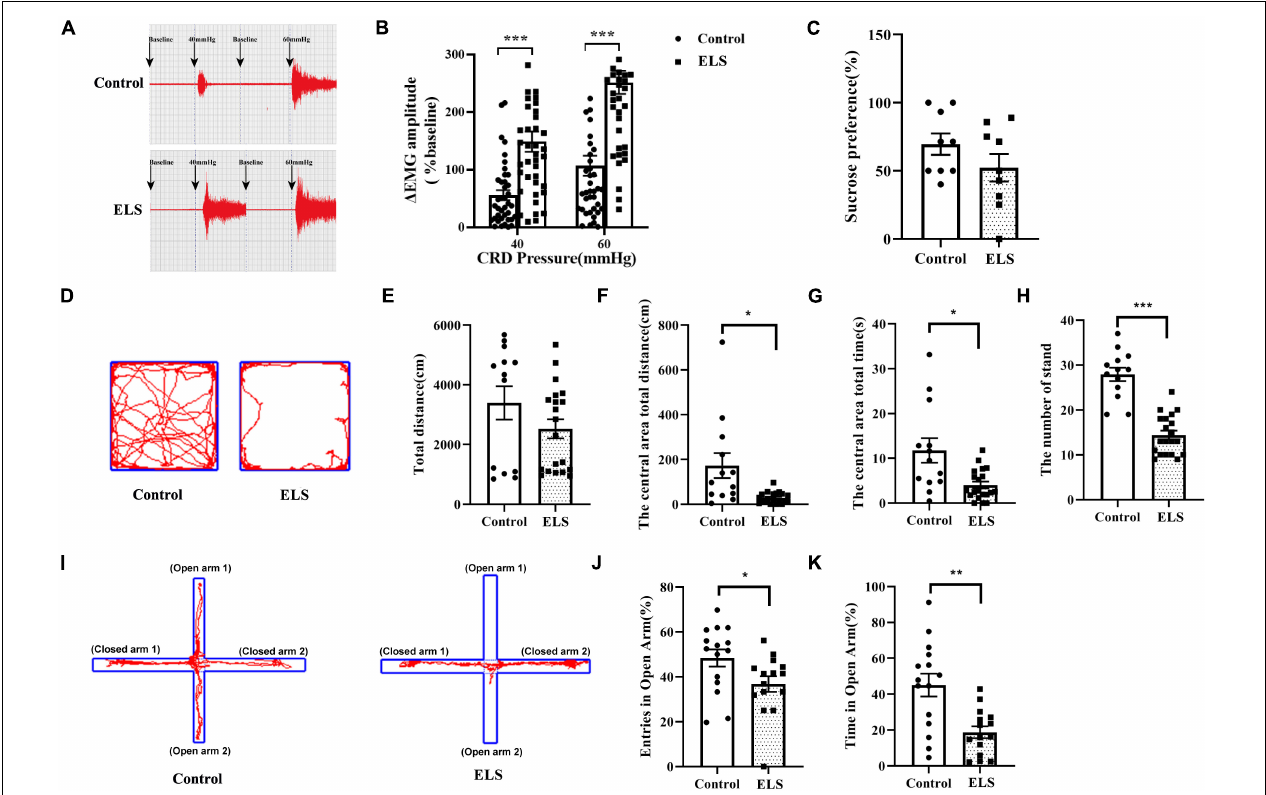
FIGURE 1 | Neonatal CRD resulted in visceral hypersensitivity and anxiety-like behaviors in adult rats. (A,B) Successful chronic visceral pain modeling with EMG assessment. The original typical traces of EMG (A) . Amplitude of (cid:49) EMG in ELS rats, compared to that of controls, shown by quantification (B) . N = 40. One-way ANOVA and Mann–Whitney U test were performed. (C) Sucrose preference test used to detect depression-like behavior in rats. N = 9. Independent samples t -test was performed. (D–H) Anxiety-like behaviors were tested in the OFT. Original traces of OFT (D) . Quantification of the total distance (E) , the central area total distance (F) , the central area total time (G) , and the number of standings in OFT (H) . N = 13–20. Independent samples t -test was performed. (I–K) Anxiety-like behaviors were tested in the EPMT. Original trajectory representation diagram of EPMT (I) . Quantification of entries (J) and time (K) in the open arms. * p < 0.05, ** p < 0.01, *** p < 0.001. N = 15. Independent samples t -test was performed (J) .One-way ANOVA and Mann–Whitney U test were performed (K) . N represents the number of rats per